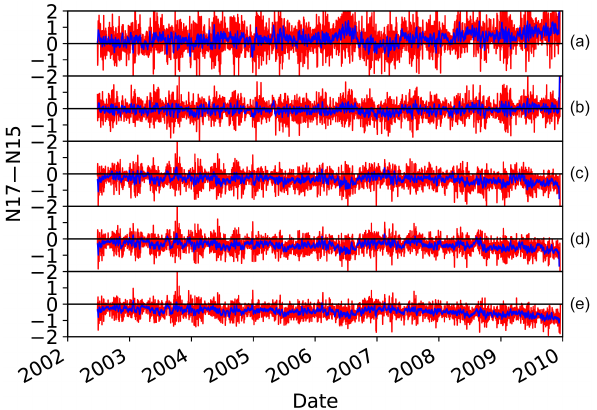
Figure 1. Differences between all-sky N15 minus N17 and clear- sky N15 minus N17 (channels 1–5 from a to e ). The values are dif- ferences between all-sky NOAA-15 and NOAA-17 measurements minus the differences between the two satellites in clear-sky condi- tions. The blue lines show the weekly-moving